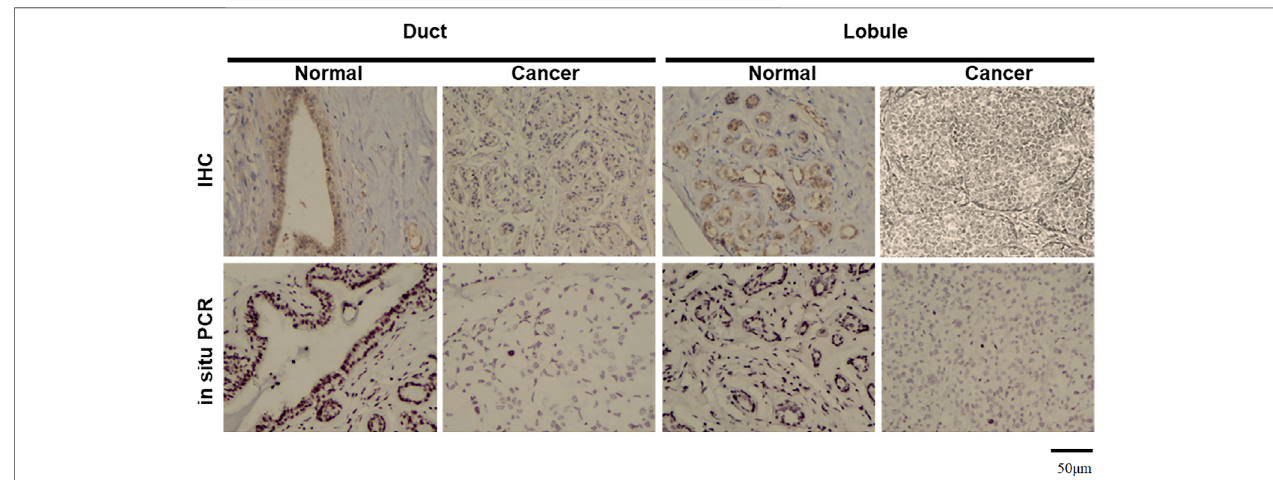
FIGURE 3 | Morphological examination of JCV T antigen in breast cancers. According to immunohistochemistry (IHC), T antigen was strongly expressed in ductal and lobular epithelial cells (brown) but positively or weakly expressed in breast ductal and lobular cancer cells. NBT/BCIP coloring is displayed as black to show positive signals in breast ductal and lobular epithelial cells by in situ PCR, while methyl green is denoted as a green color for counterstaining.